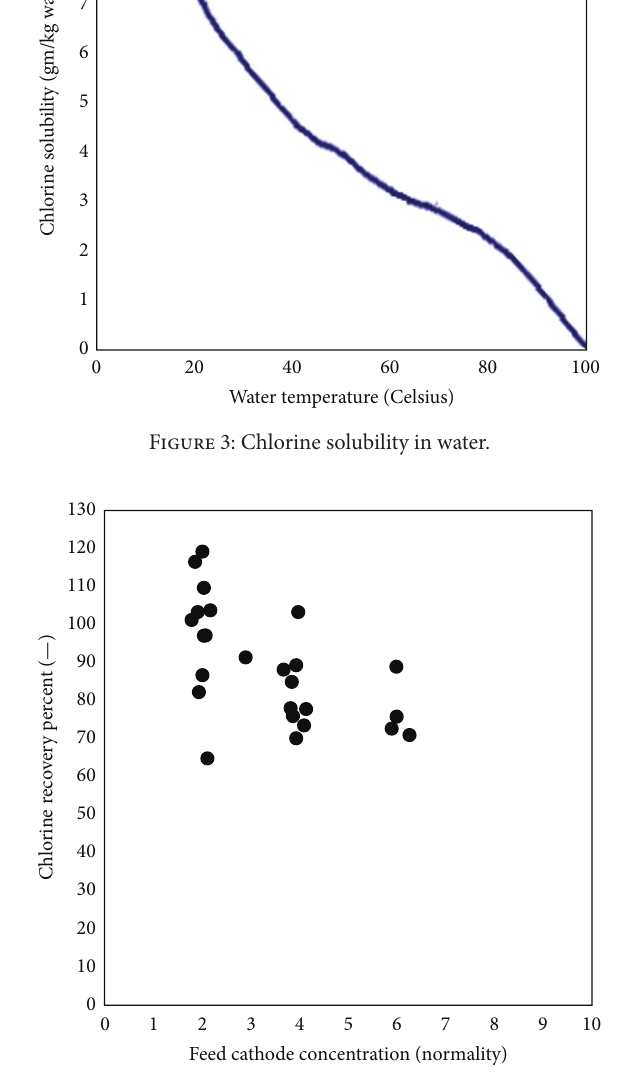
Figure 4: Chlorine recovery percent (—) versus feed catholyte concentration (normality).